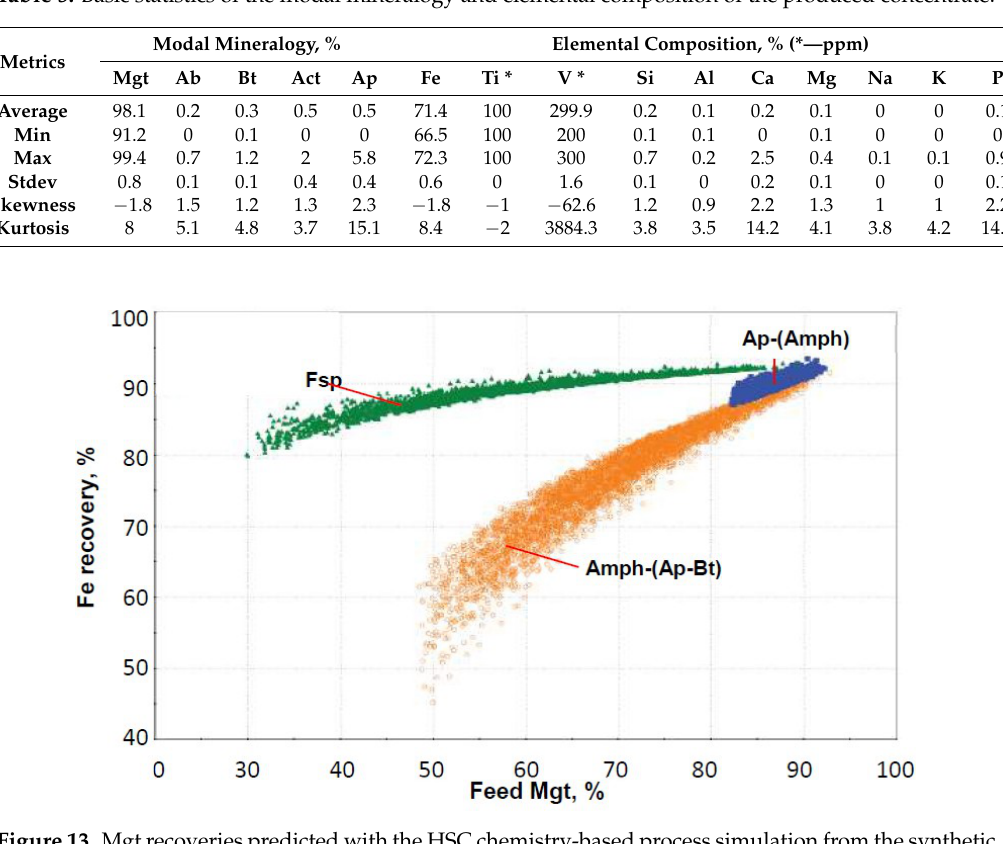
Figure 13. Mgt recoveries predicted with the HSC chemistry-based process simulation from the synthetic ore body model. (Abbreviations: Mgt—magnetite; Ap—apatite; Bt—biotite; Amph—amphiboles; Fsp—K feldspars).